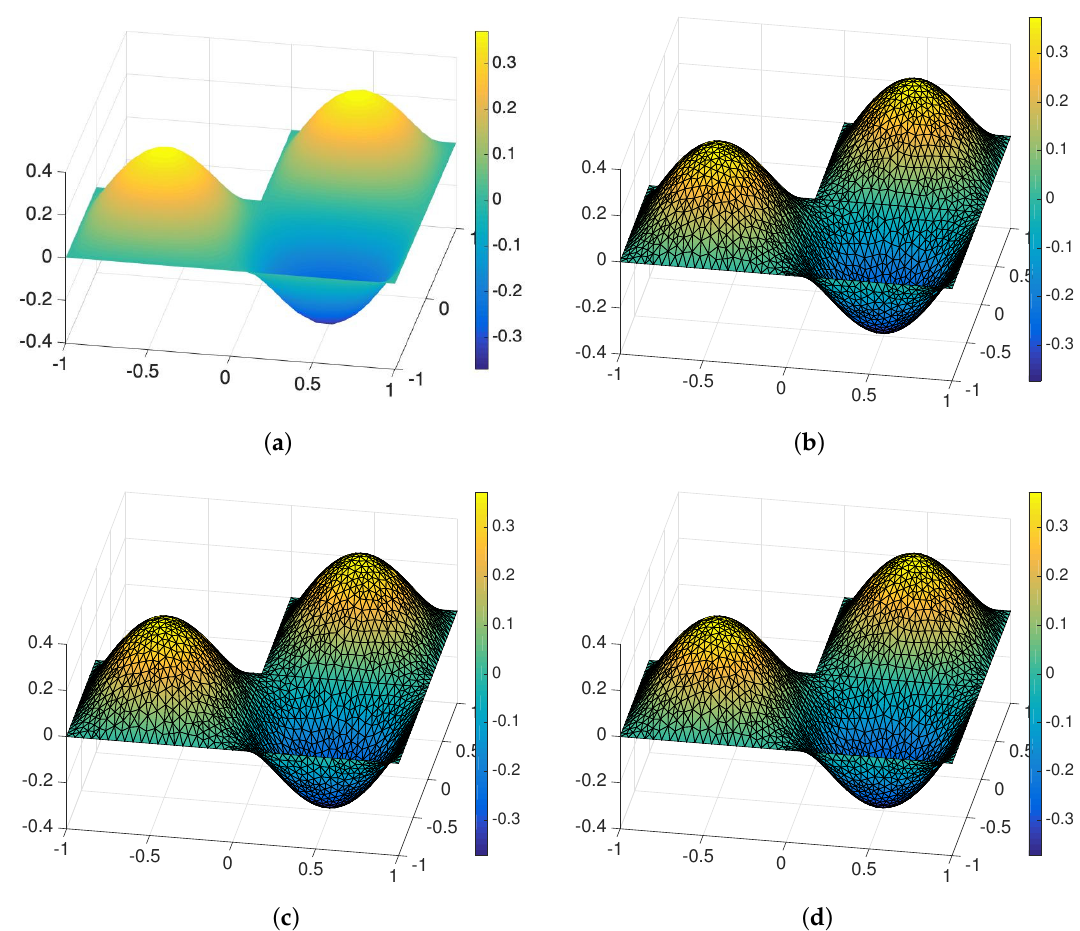
Figure 2. ( a ) The exact solution; ( b ) the backward-Euler FEM solution with the left rectangular quadrature rule applied to approximate the Volterra integral term; ( c ) the backward-Euler FEM solution with the right rectangular quadrature rule applied to approximate the Volterra integral term; ( d ) the Crank–Nicolson FEM solution with the trapezoidal quadrature rule applied to approximate the Volterra integral term. All plots are for T = 0.1, and the FEM solutions were computed using P1 elements with τ = 0.00125 and h = 0.05.